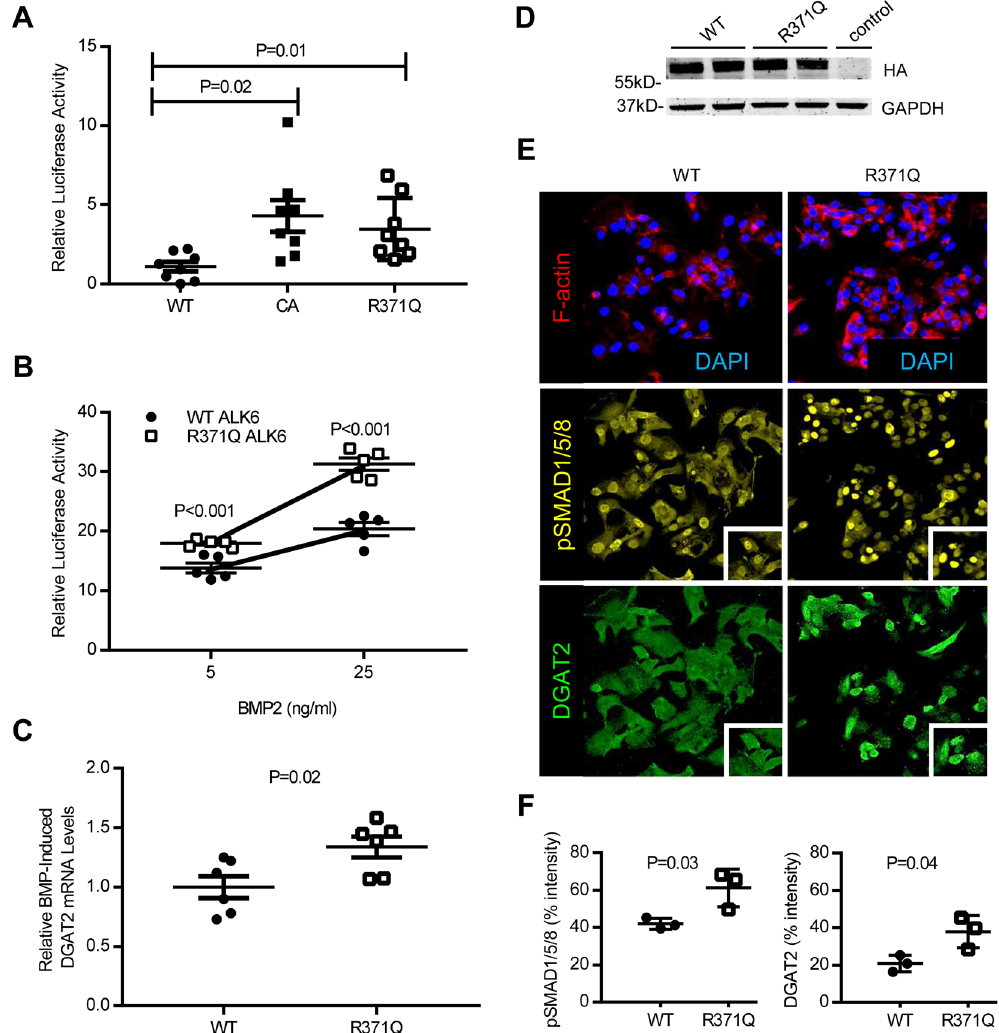
Figure 6. The ALK6 (Activin Receptor-Like Kinase 6) mutant R371Q is a constitutively active BMP type 1 receptor that is hyper-responsive to BMP ligands. C2C12BRA cells were stably transfected encoding a luciferase downstream of the BMP response element promoter (BRE-LUC), as well as either wild-type ALK6 (WT), a constitutively active ALK6 (CA), or R371Q ALK6. The ALK6 mutant R371Q (which results from the rs34970181_A variant) had increased baseline BMP signaling activity compared to WT ALK6 ( A , eight replicates per group). Compared to WT ALK6, the R371Q ALK6 variant had increased BMP signaling in response to BMP2 ( B , five replicates per group). Compared to WT ALK6, expression of the R371Q ALK6 variant in HepG2 cells resulted in increased BMP-induced DGAT2 (diacylglycerol O-acyltransferase 2) mRNA levels ( C , six replicates per group). Equal levels of expression of WT and R371Q ALK6 was confirmed by Western blot using antibodies detecting the HA epitope tag ( D ). GAPDH was used as a loading control. Immunofluorescence staining of HepG2 cells for pSMAD1/5/8 and DGAT2 transfected with wild-type ALK6 or R371Q ALK6 ( E ) and quantified using quantitative microscopy ( F , % intensity represents signal of fluorophore vs background). The comparisons for ( A ) were performed using a 1-way ANOVA with Sidak’s multiple comparison testing and, for ( B , C , F ), two-tailed Student’s t test was